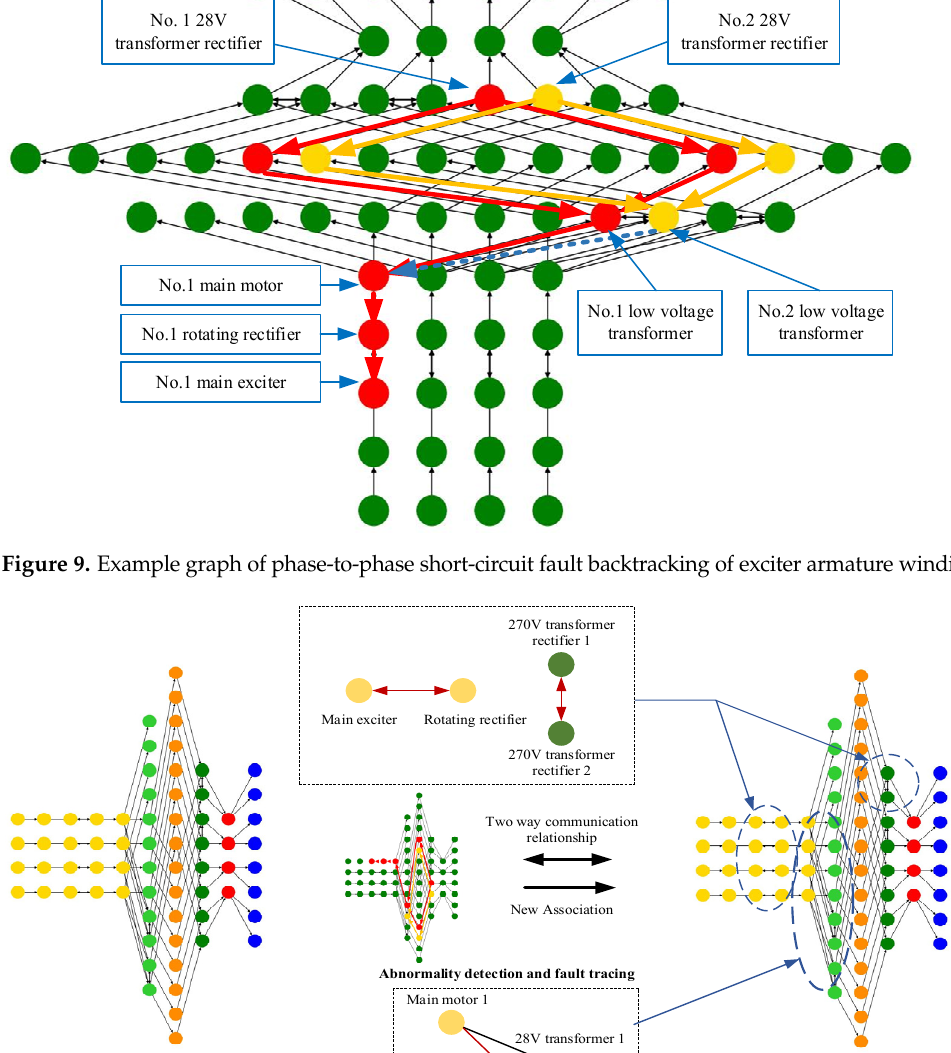
Figure 9. Example graph of phase-to-phase short-circuit fault backtracking of exciter armature winding.